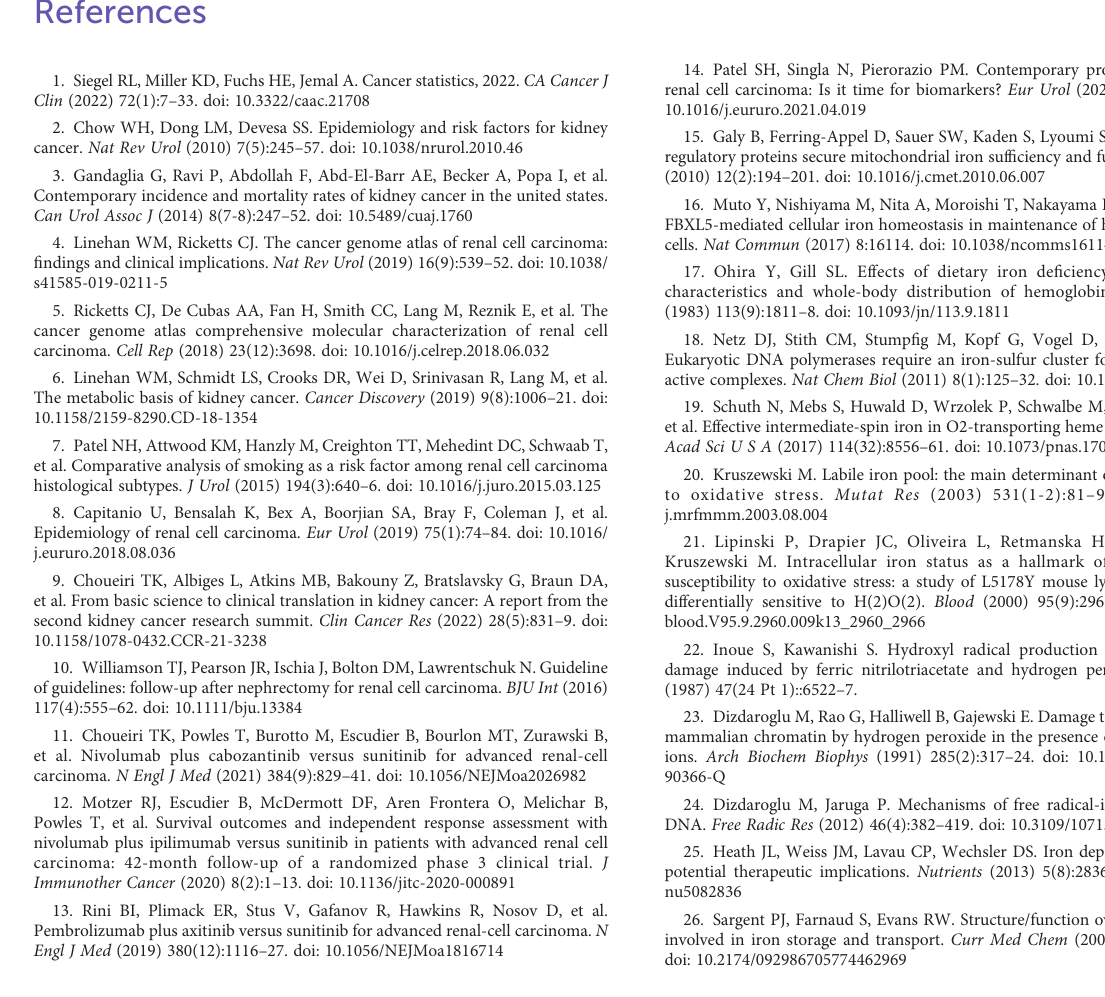
SUPPLEMENTARY FIGURE 1 Association of primary tumor iron levels with non-ccRCC patient survival outcomes. Iron levels in non-ccRCC patients were measured using Prussian Blue stain of the RPCCC RCC patient TMA set. Iron staining levels (H-score) in (A) primary tumor cells, (B) tumor microenvironment and (C) normal (non-neoplastic) kidney were tested for association with (left to right) metastasis-free survival, cancer-speci fi c survival, and overall survival using Kaplan – Meier